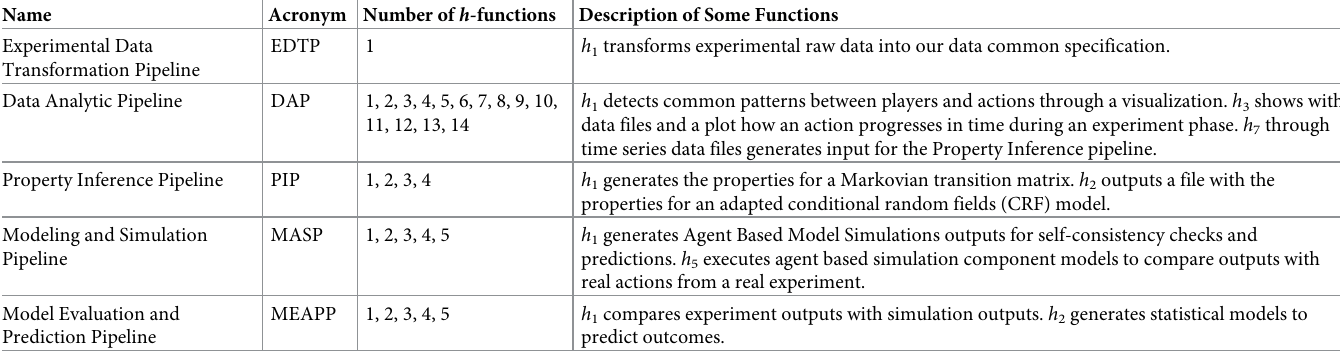
Table 7. Summary table of h